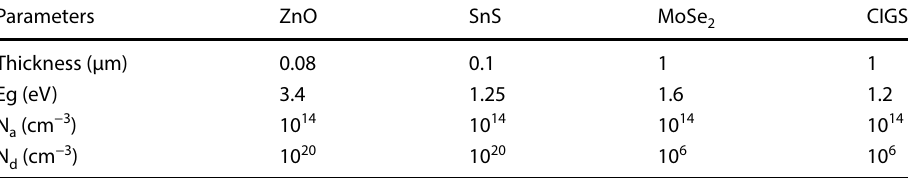
Table 1 Materials Parameters used in solar cell simulation